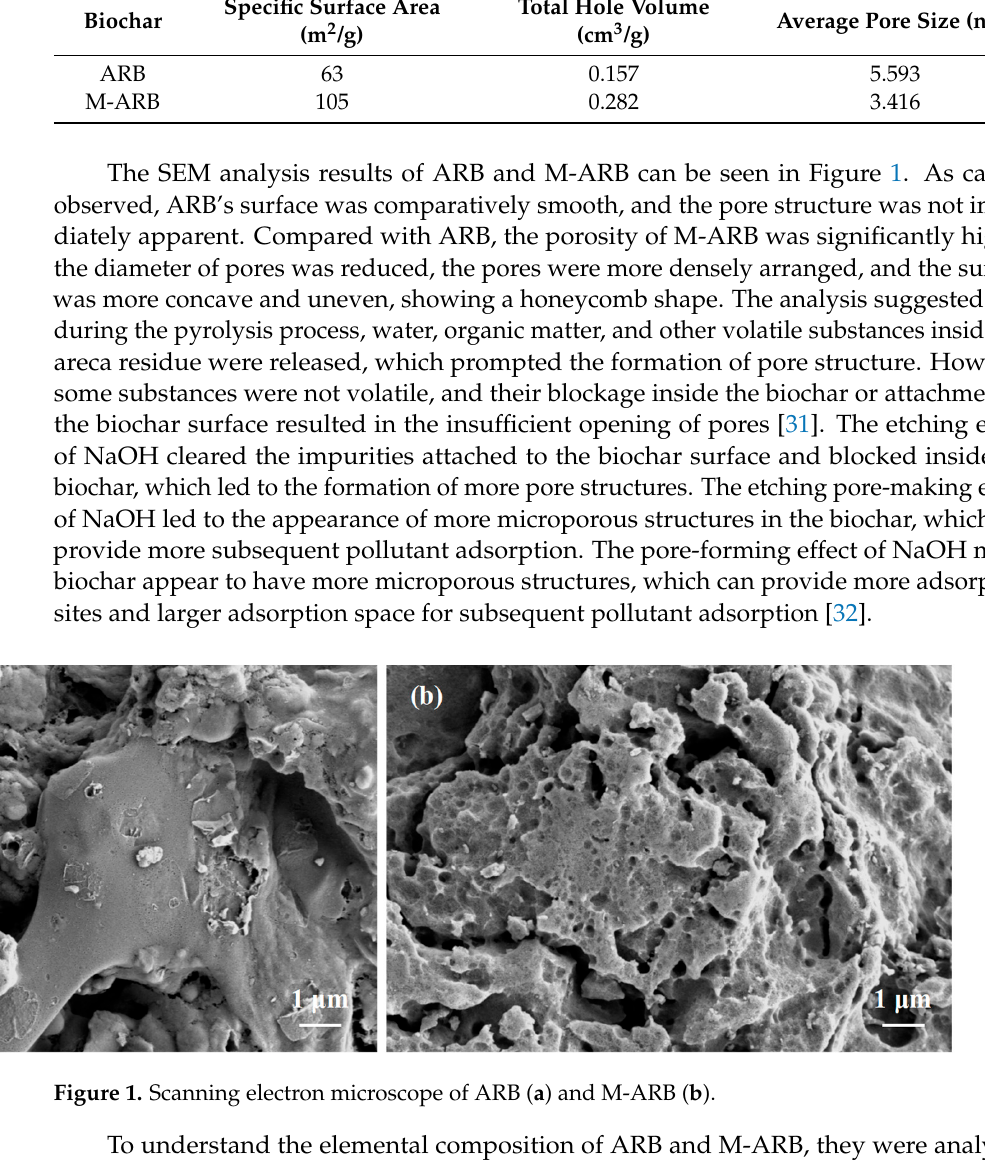
Figure 2. EDS analysis results of ARB ( a ) and M-ARB ( b ). 3.2. Analysis of Adsorption Influencing Factors 3.2.1. Effect of Initial pH of the Solution The effect of the initial pH upon the effect of ARB and M-ARB on the adsorption of MB can be seen in Figure 3. The adsorption and removal rate of MB by ARB and M-ARB increased rapidly in the interval of pH range from 2 to 4. In the interval of the pH range from 4 to 8, the increasing trend of the MB removal effect became slower. In the interval of pH range from 8 to 10, the increasing rate of MB removal became fast again, but showed a decreasing trend after the pH exceeded 10. When the solution’s original pH was 10, the adsorption value of MB by ARB and M-ARB were 86.23 mg/g and 120.05 mg/g, respec- tively, reaching the maximum adsorption value at this pH condition, while the adsorption of M-ARB was significantly higher than that of ARB, and its corresponding MB removal rate was increased by 27.06%, compared with that of ARB. This showed that the alkaline 0